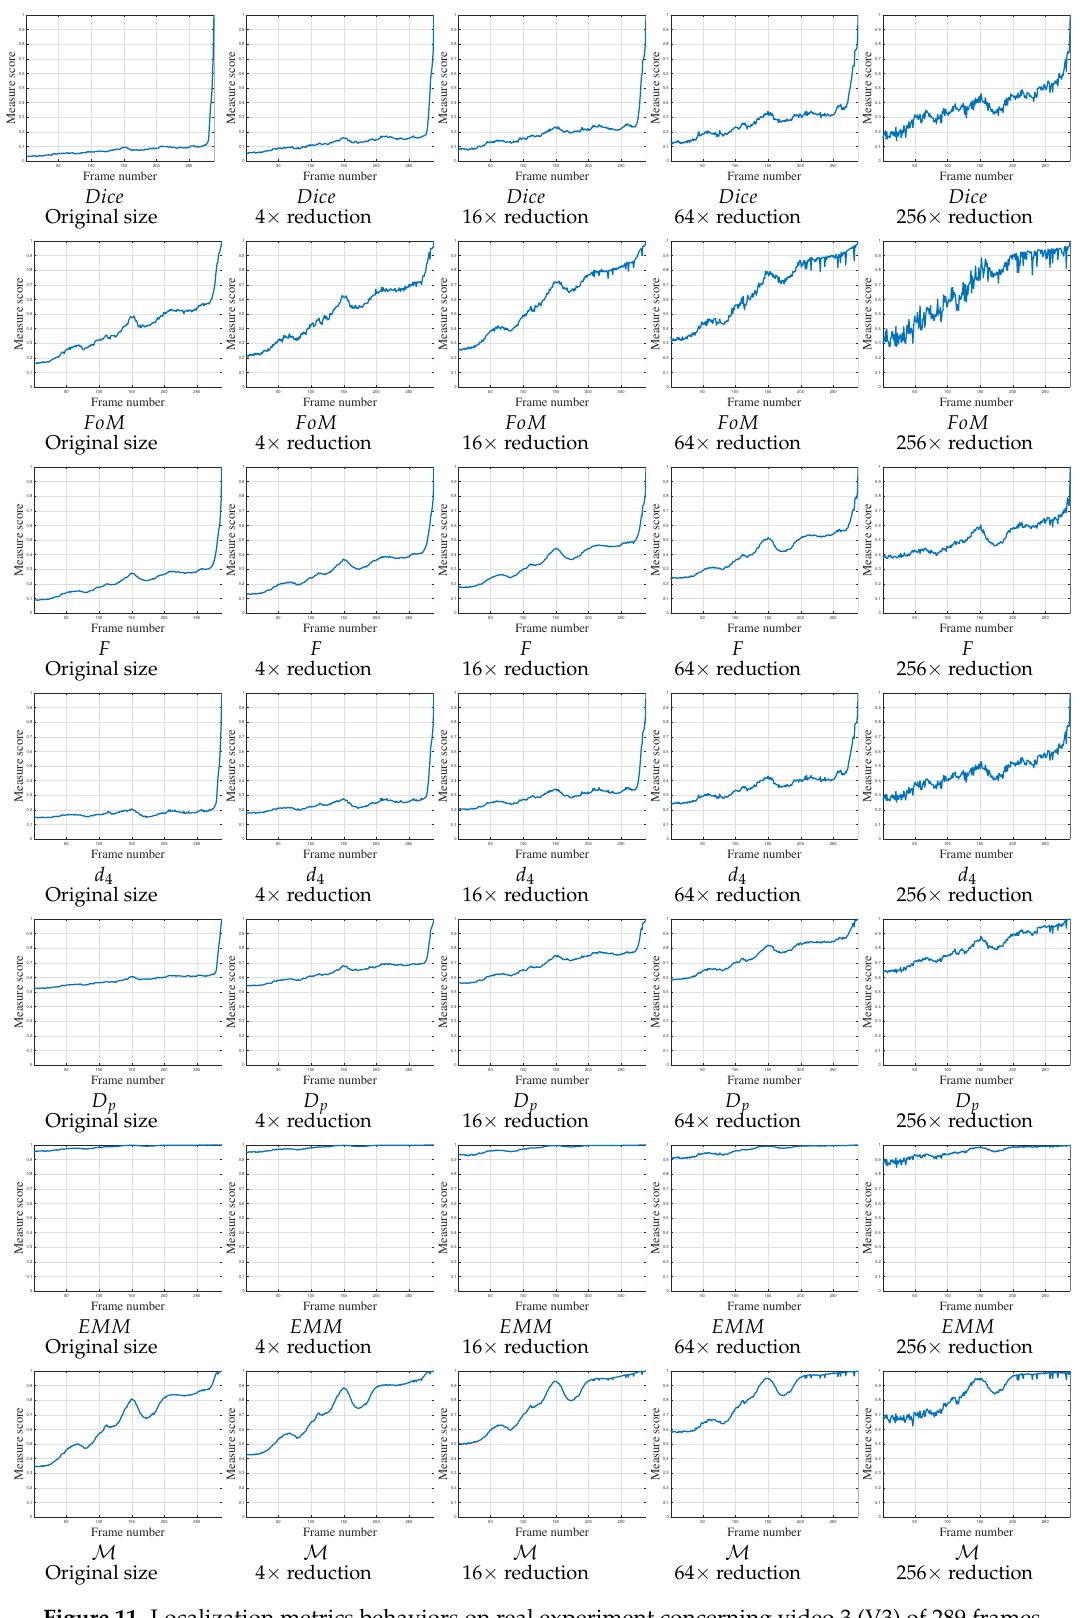
Figure 11. Localization metrics behaviors on real experiment concerning video 3 (V3) of 289 frames. The parameter concerning FoM , F , d 4 and D p is κ = 1/9. Concerning M , the parameters are µ FP = 1/ ∆ 2 and µ FN = 1/ ∆ , so µ FP < µ FN